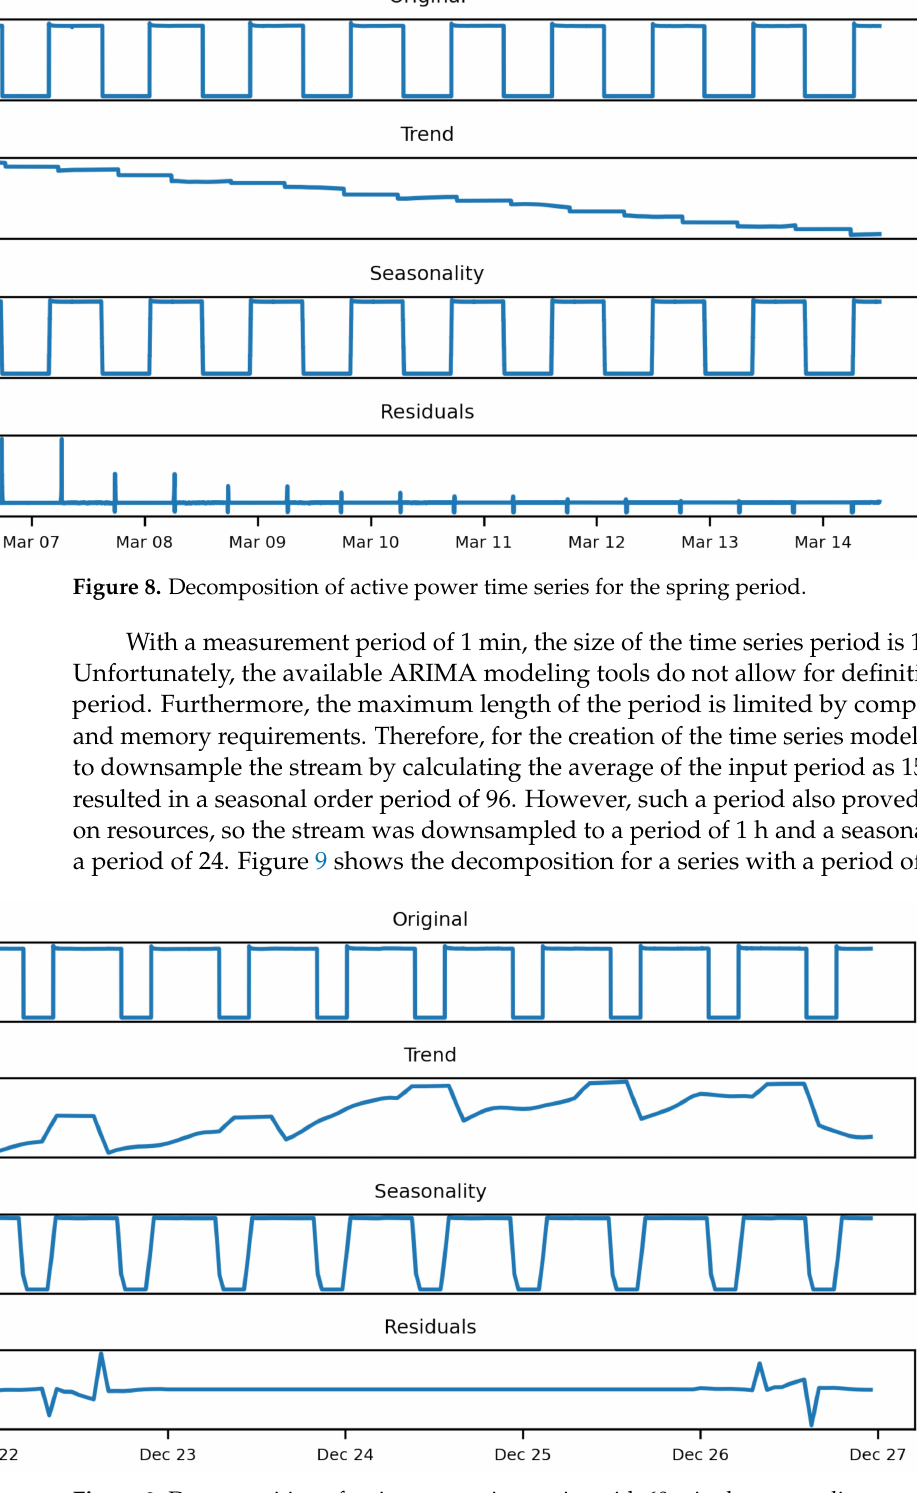
Figure 9. Decomposition of active power time series with 60 min